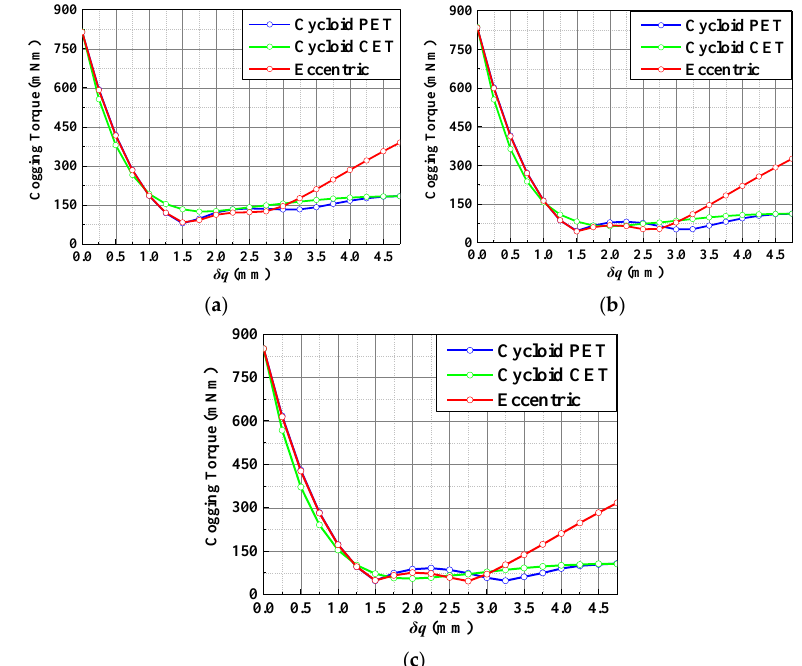
Figure 10. Cogging torque according to δq of each curve for a typical manufacturing tolerance model: ( a ) fabrication tolerance for position of permanent magnet; ( b ) fabrication tolerance for residual magnetic flux density of permanent magnet; ( c ) fabrication tolerance for width of open slot.